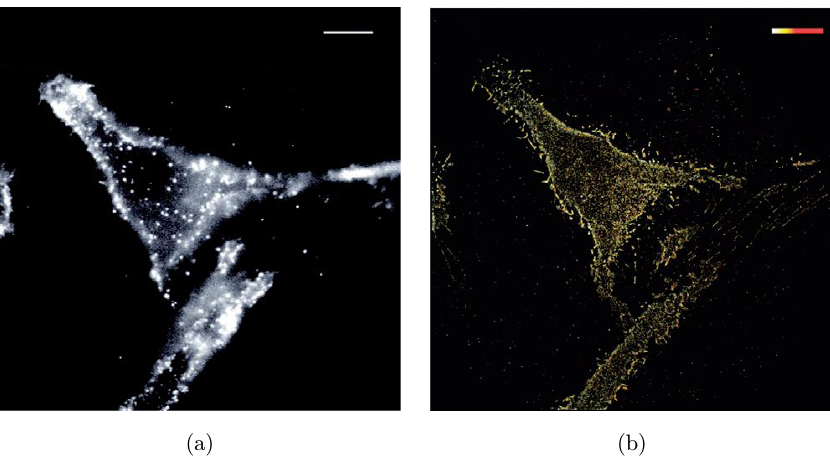
Fig. 8. STORM imaging of Sia in HeLa cells by metabolically labeling with Ac 4 ManNAl and interaction with Alexa Fluor 647 azide. (a) Single STORM image (100th frame) from a sequence. (b) The STORM image reconstructed from 480 consecutive frames. The color bar represents the integrated °uorescent intensity of each molecule. Scale bars: 10 (cid:1) m. Adapted with permission from Ref. 94.